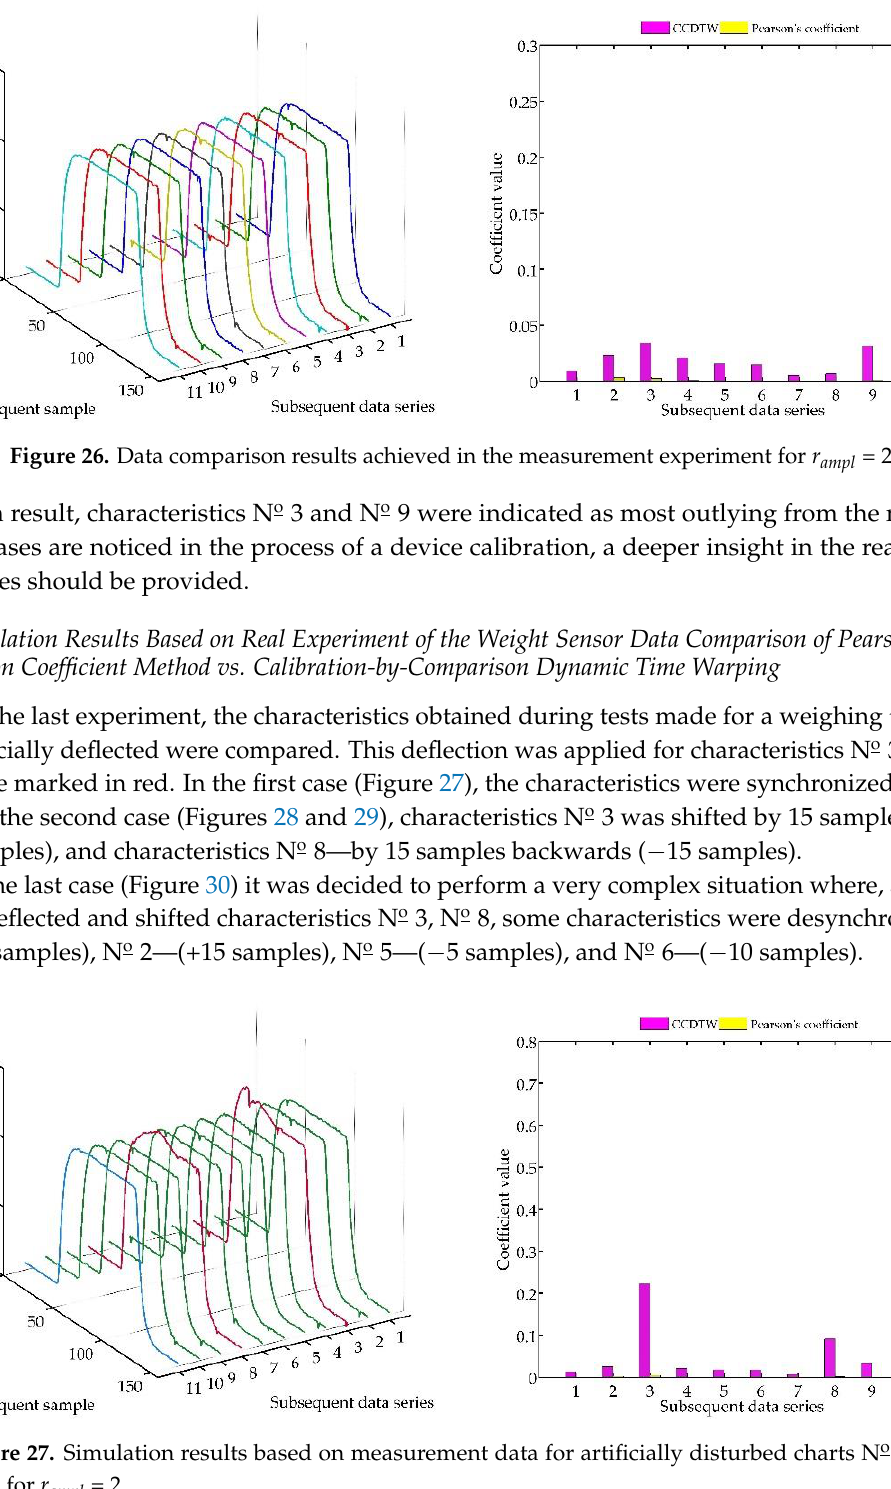
Figure 26. Data comparison results achieved in the measurement experiment for r ampl = 2.